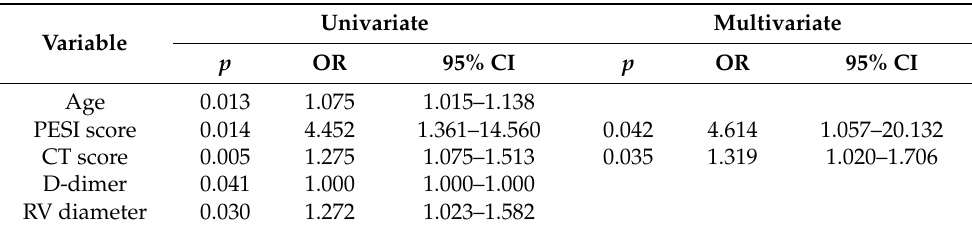
Table 8. Univariate and multivariate logistic regression analyses with the need for oxygen support as a dependent